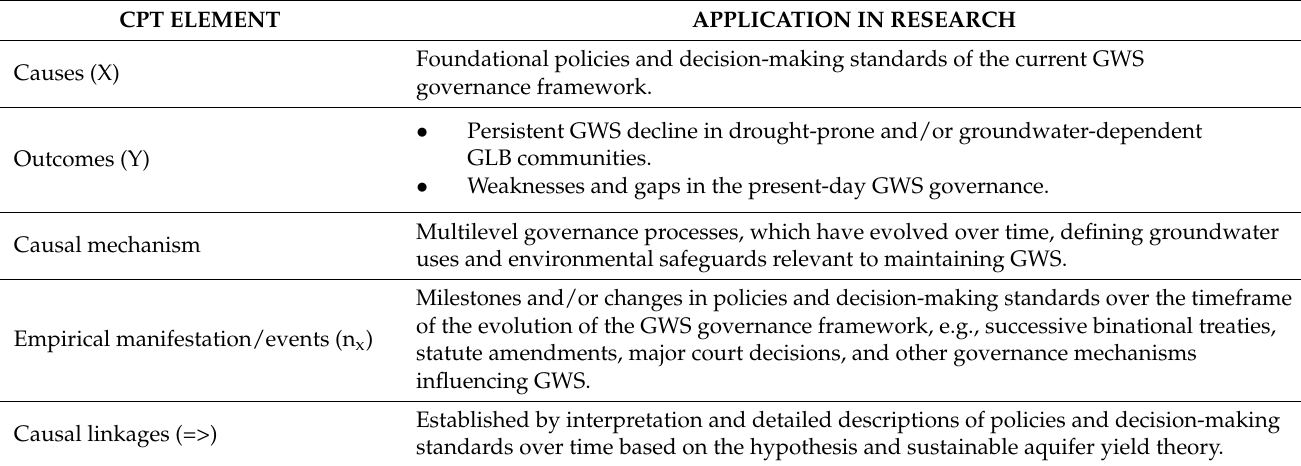
Table 1. Causal process tracing application in research